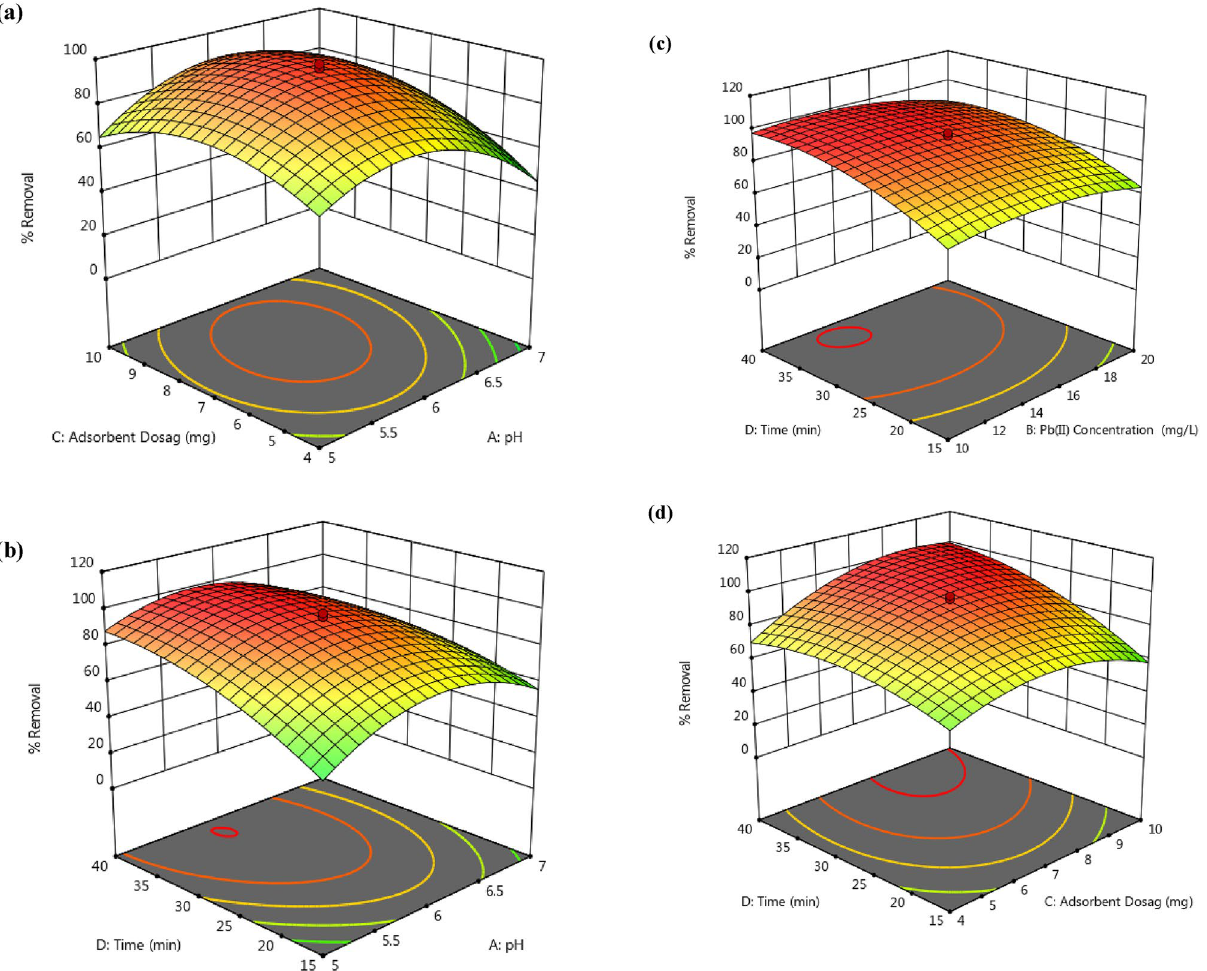
Figure 12. 3D response surface plots of Pb(II) adsorption on Pip@MGO nanocomposite.